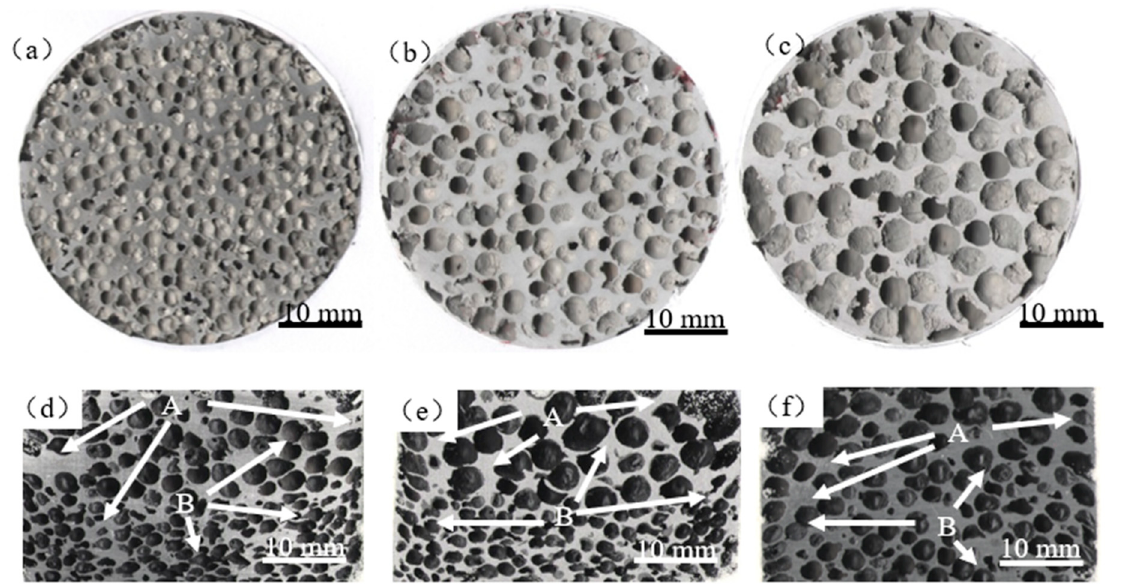
Figure 1. Macrostructure of two-layered cell-size gradient Al foams in both orthogonal direction; transverse direction: Al foams with cell of ( a ) 2 mm, ( b ) 3 mm, ( c ) 4 mm, longitudinal direction: Al foams with cell of ( d ) 3 mm-2 mm, ( e ) 4 mm-2